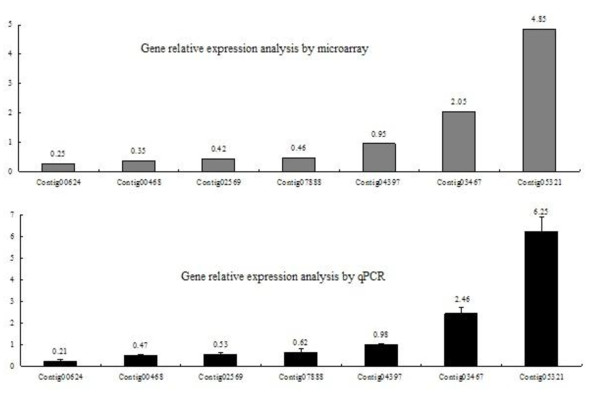
Result of qPCR confirmation of gene microarray data subset.